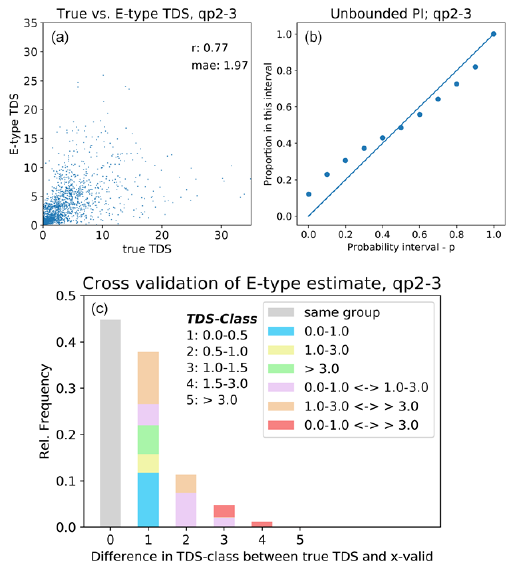
Figure 10. Results of the cross-validation for aquifer qp2-3. Panel (a) shows scatterplot of true versus E-type TDS estimates; panel (b) indicates the accuracy of the interpolation by proportion of data that fall in a certain probability interval (PI); panel (c) shows the summary of the cross-validation results concerning grouping of TDS values. For further explanation refer to the main